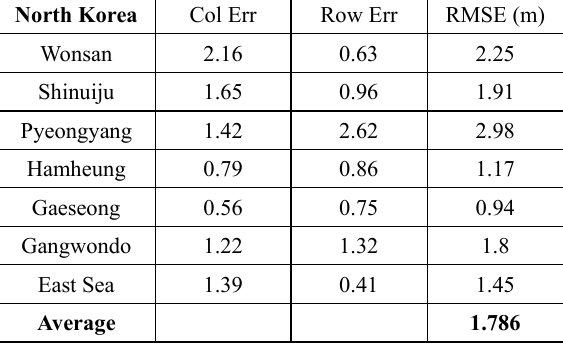
Table 9. Geolocation accuracy of precise orthoimage (North Korea).